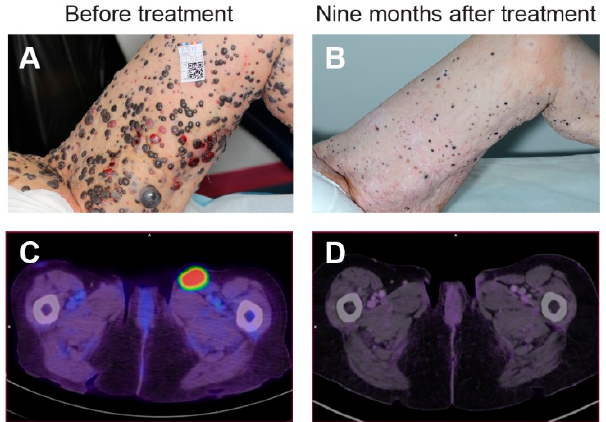
Figure 5. Systemic immune response after calcium electroporation. A patient with cutaneous metastases from malignant melanoma was treated with electrochemotherapy using intravenous bleomycin. Four months after treatment of some of the multiple metastases, new metastases appeared. Two of these were treated ( A ), one with calcium electroporation and one with electrochemotherapy using intratumoral bleomycin, both with complete response within 6 months. Nine months after this treatment complete levelling of all cutaneous metastases appeared ( B ) as well as no or limited signs of previously enlarged lymph nodes on PET / CT scan ( C , D ). Adapted from Falk et al., 2018 [19].